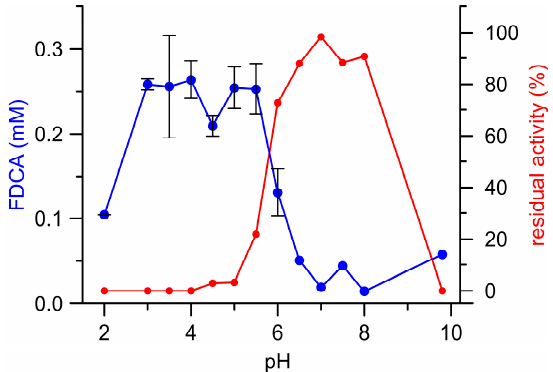
Figure 3. Aae UPO catalyzed formation of FDCA (blue) from FFCA as well as the corresponding residual UPO activities (red) in dependence on the pH.